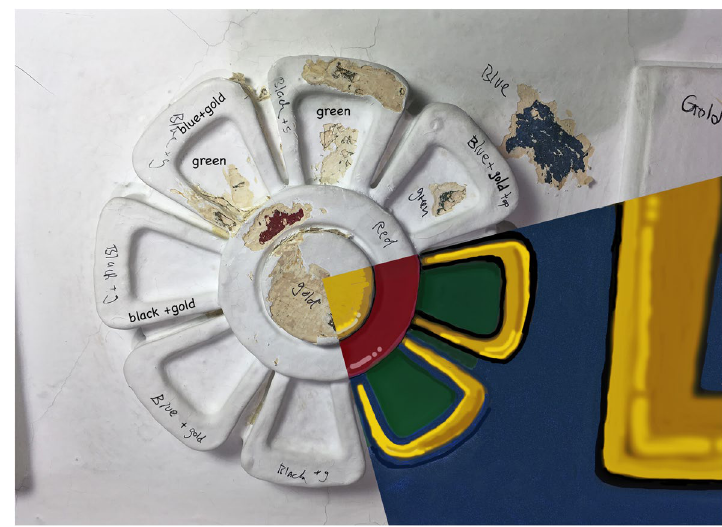
Fig. 9 Detail of ceiling decoration (flower in the meander band around the main ceiling panels), indicating the colour scheme on-site and